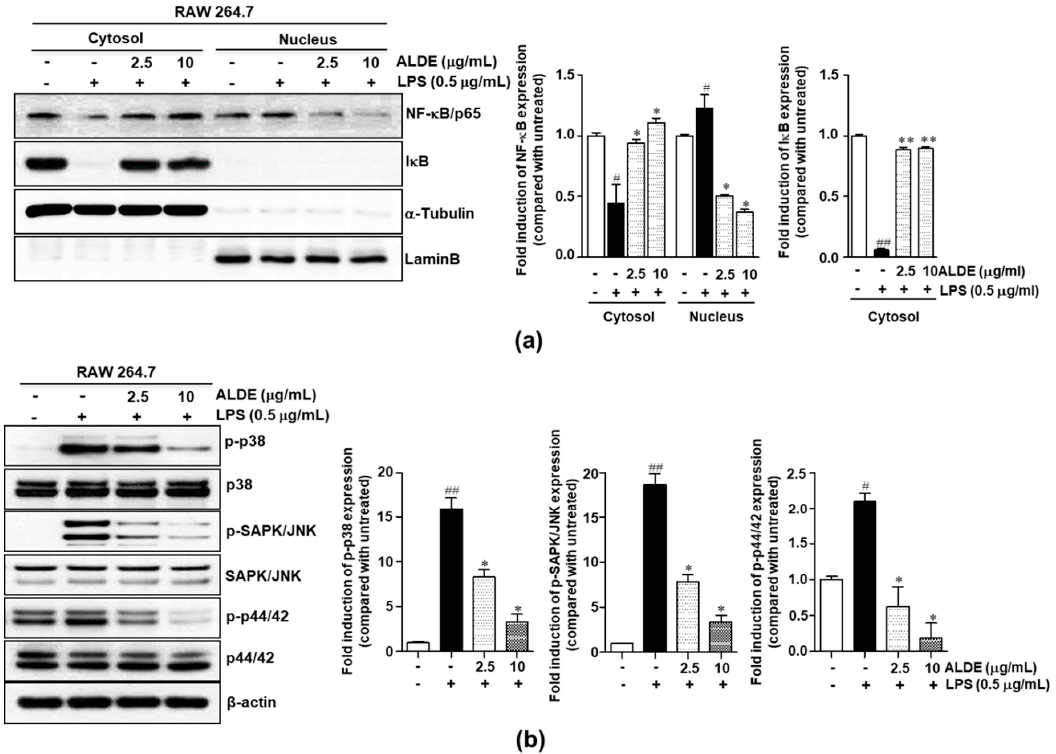
Figure 5. Inhibitory e ff ects of ALDE on the nuclear translocation of NF- κ B and the MAPK signaling pathway. RAW 264.7 cells were pretreated with ALDE (0, 2.5, and 10 µ g / mL) for 2 h and then stimulated with LPS (0.5 µ g / mL) for 15 min. Cytosolic extracts and nuclear extracts were prepared. ( a ) The expression of NF- κ B / p65 and I κ B was detected by Western blotting; α -tubulin was used as a cytosolic loading control and Lamin B was used as a nuclear loading control. ( b ) The expression of the proteins associated with the MAPK signaling pathway (p38, p44 / 42 ERK, and JNK) was detected by Western blotting, with β -actin used as a loading control. The relative density of the protein expression was normalized to each loading control and is presented in quantitative graphs. The data presented are the mean ± SEM of three independent experiments. Di ff erences between groups were analyzed using